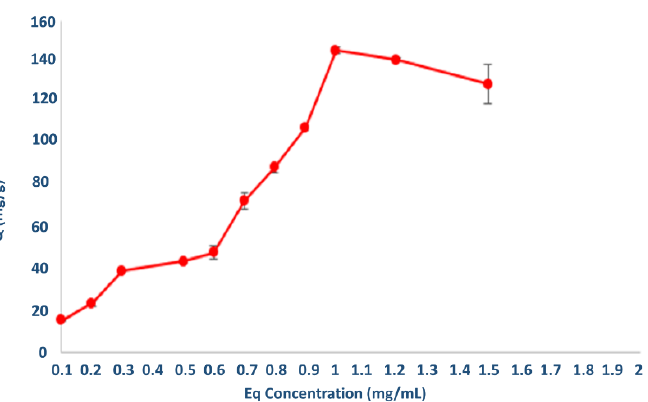
Figure 7. Effect of initial AML concentration on the adsorption capacity of p(HEMPA) (100 mM phosphate buffer pH 7.4, 60 min, and 25 °C).